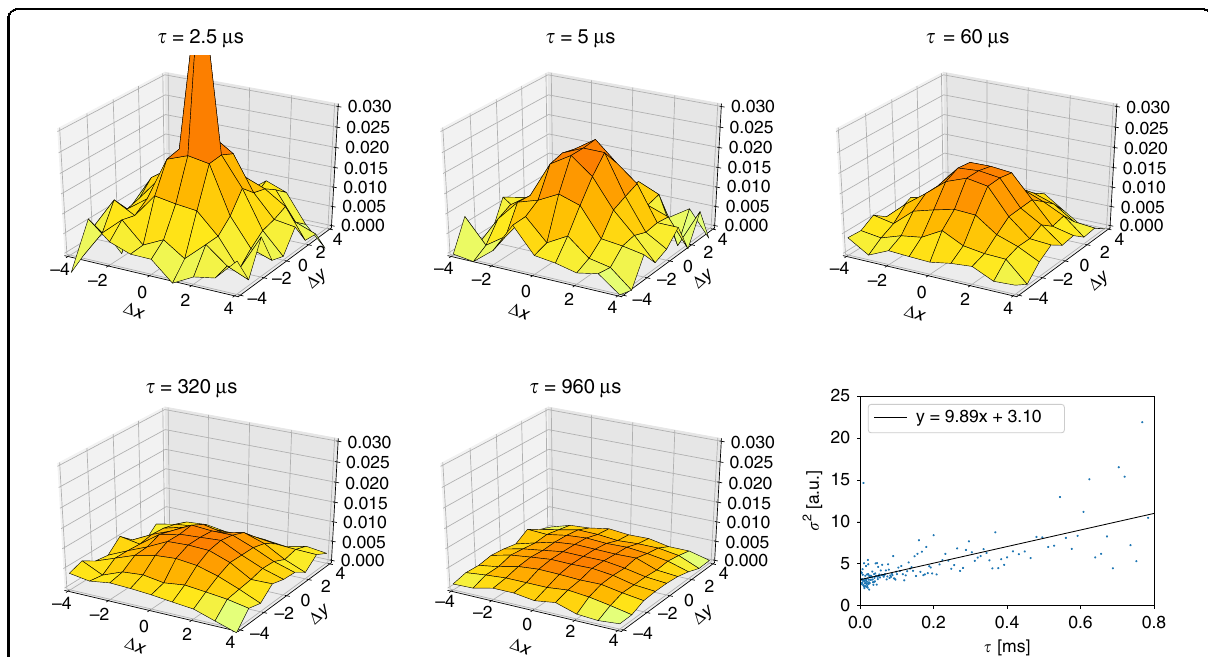
Fig. 5 STICS analysis on the Alexa 488 sample for different τ values. The peak at (0, 0) for τ = 2.5 µs is the consequence of detector after-pulsing. This peak was removed in the other panels for visualisation purposes. The line plot shows the variance of the 2D Gaussian fi ts σ 2 (expressed in terms of pixels on the SPAD detector) as a function of τ . The diffusion coef fi cient calculated from the slope is 27.8 µm 2 s −